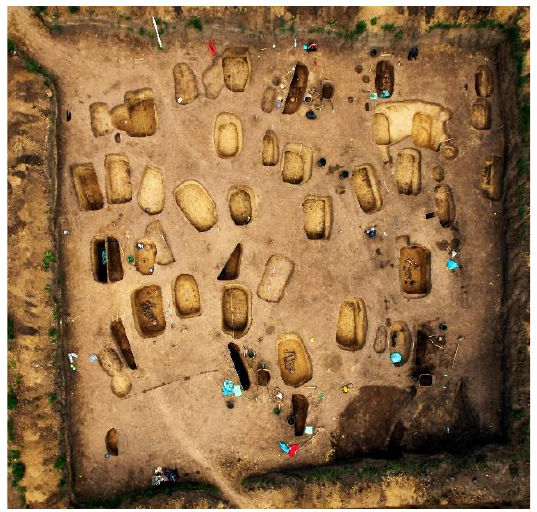
Figure 3. Mikulovice (Pardubice Region), “V loučkách” site. Area of a family house with a large number of graves from the Bronze Age (1800 – 1600 BC). The research required a considerable amount of time and